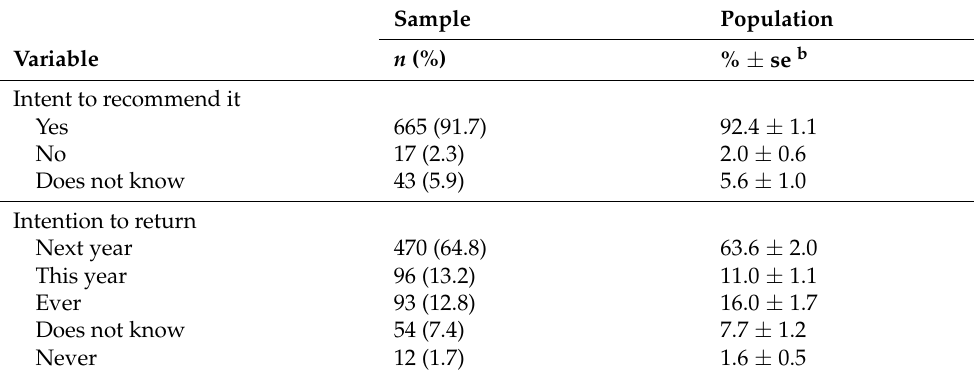
Table 2. Distribution of the variables of future intention of users ( n = 725) a